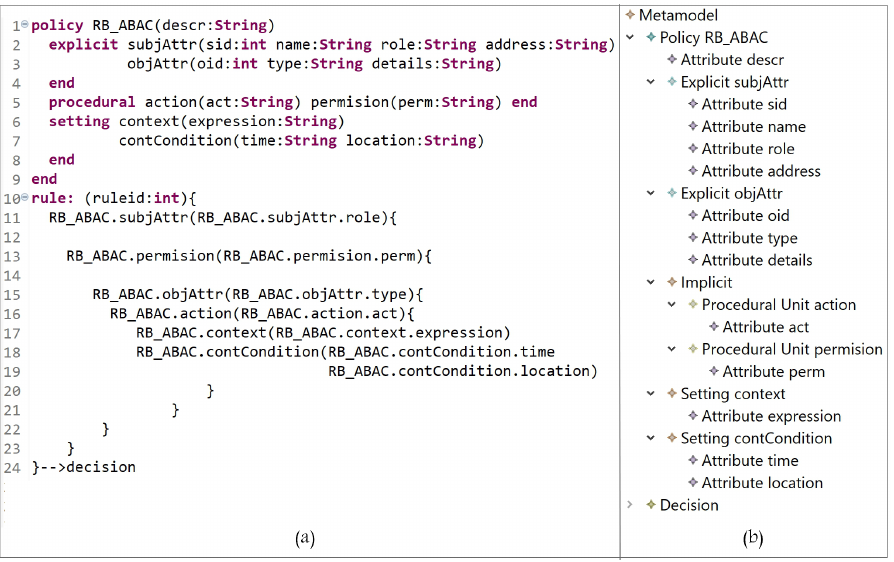
Figure 17. ( a ) RBAC/ABAC policy definition; ( b ) RBAC/ABAC